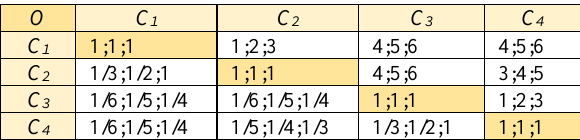
Table 1. Matrix of pairwise comparisons of criteria against the overall objective